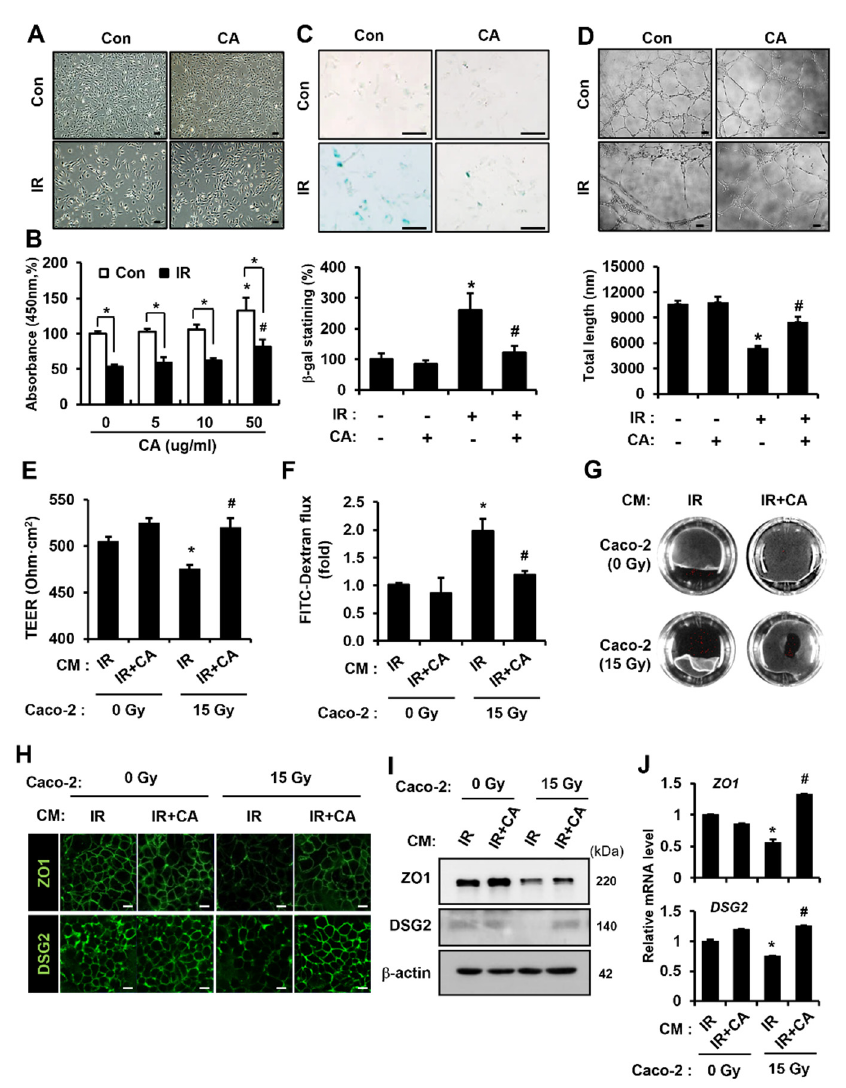
Figure 1. Centella asiatica -treated endothelial cells are recovered from radiation-induced dysfunction and protect against epithelial barrier damage. ( A ) Morphology and ( B ) viability of HUVECs after irradiation and treatment with Centella asiatica (CA). The effect of CA on HUVEC viability was assessed by CCK-8 assay. Bars represent the percentage of survival cells normalized to that of the corresponding control. Scale bars represent 100 µm. ( C ) Senescent activity of CA. Senescent HUVECs were quantified by a b-galactosidase assay. Senescent HUVECs were quantified and plotted as a bar graph (right). ( D ) Angiogenic activity assay. HUVECs were re-seeded onto Matrigel-coated wells in the presence or absence of CA. Total segments length per five fields were quantified and plotted as a bar graph (right). ( E ) The transepithelial electrical resistance (TEER) value of Caco-2 monolayers. The groups are as follows: conditioned medium (CM) of irradiated (IR)-HUVECs treating non-irradiated Caco-2 monolayers, CM of CA-treated irradiated (IR + CA)-HUVECS treating non-irradiated Caco-2 monolayers, CM of IR treating irradiated Caco-2 monolayers, and CM of IR + CA treating irradiated Caco-2 monolayers. ( F ) The flux of FITC-dextran (4 kDa) in the lower-chamber and ( G ) Dispase-based dissociation activity of each Caco-2 monolayer. ( H ) The intensity of zonula occludens 1 (ZO1) and desmoglein 2 (DSG2) on intercellular junction of Caco-2 monolayers and ( I ) protein levels of ZO1 and DSG2. ( J ) mRNA levels of ZO1 and DSG2 were assessed by qRT-PCR. Data are presented as the mean ± standard deviation of the mean; n = 3 per group. * p < 0.05 compared to CM of IR treating non-irradiated Caco-2 monolayers; # p < 0.05 compared to the CM of IR treating irradiated Caco-2 monolayers. Scale bars represent 10 µm. All data represent at least two independent experiments.